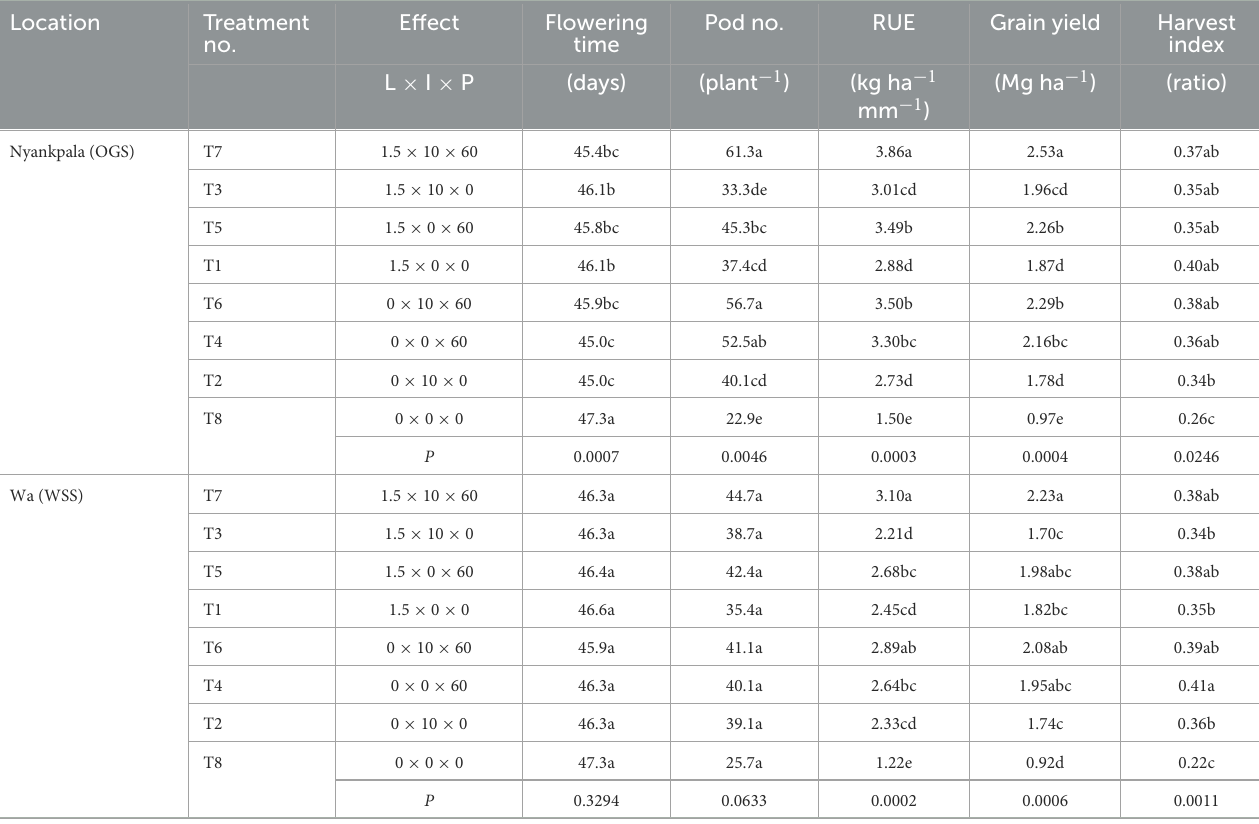
TABLE 6 Interactive effects of lime (L) × inoculum (I) × phosphorus (P) on yield components, rainfall use efficiency, yield, and harvest index at Nyankpala, and Wa locations in the northern savannas of Ghana.